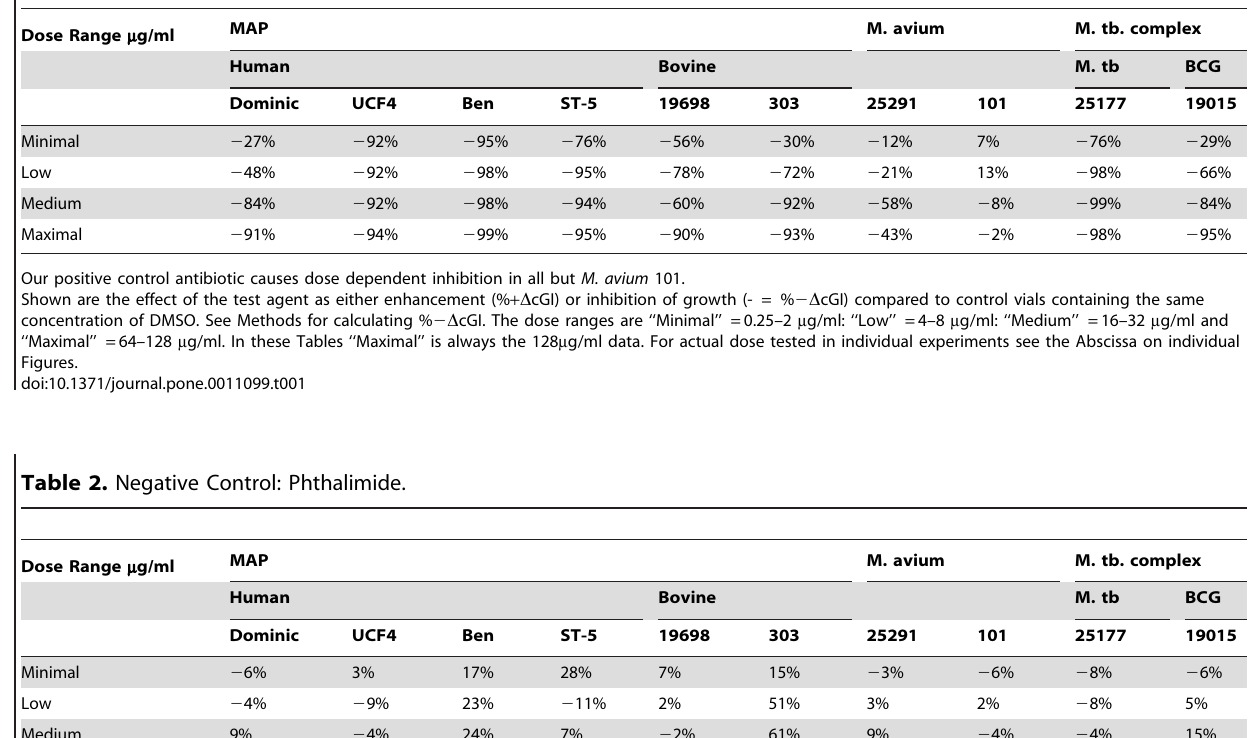
Table 1. Positive Control: Monensin.